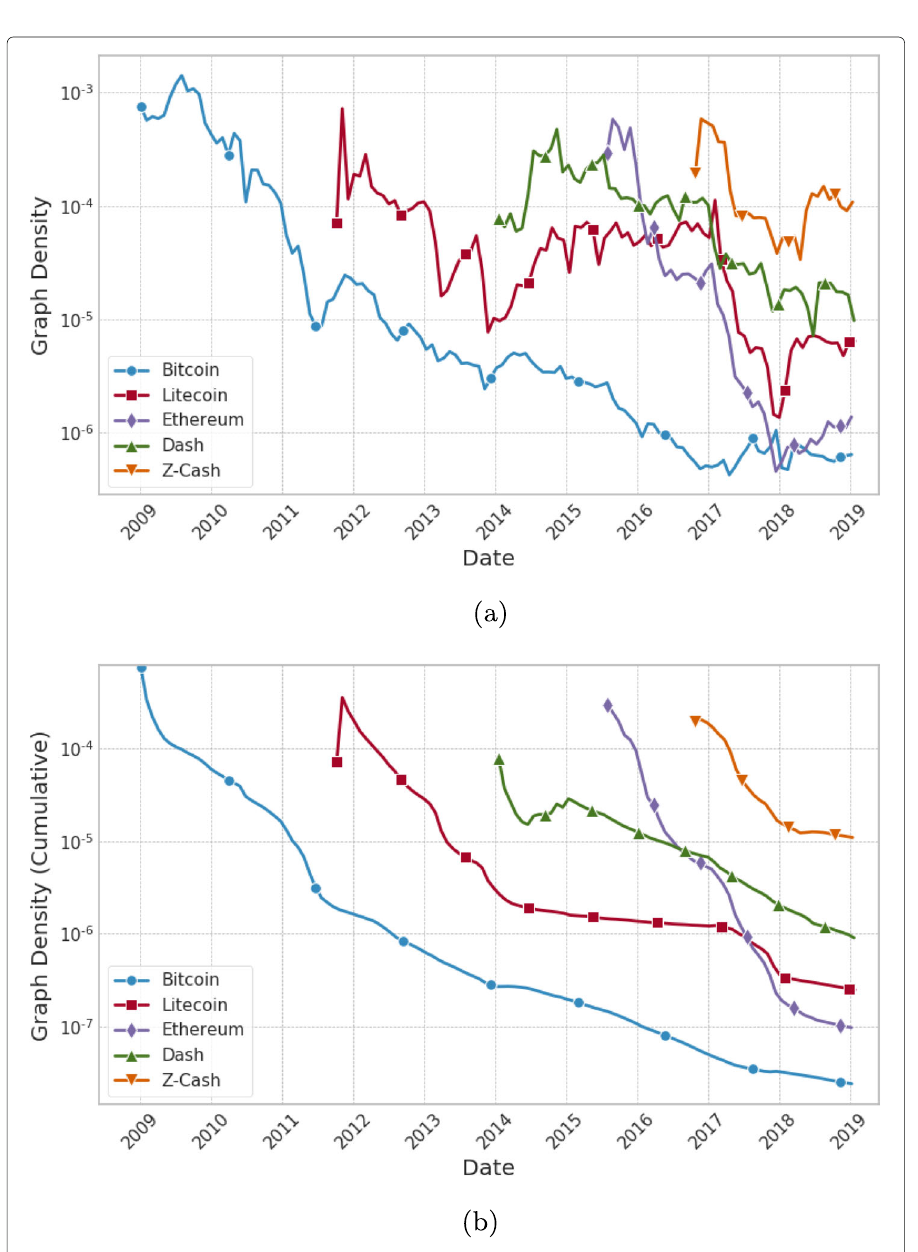
Fig. 4 Density of transactions graphs over time. a Density of MTG graph. b Density of CMTG graph